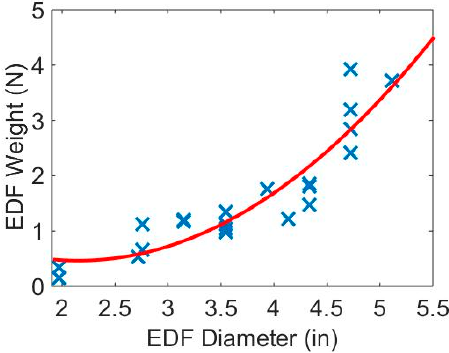
Figure 2. Weight statistical regression for EDF.